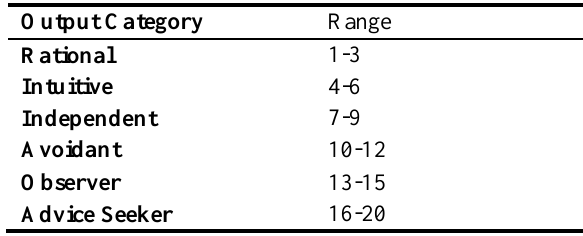
Table 2. Output Varialbes and